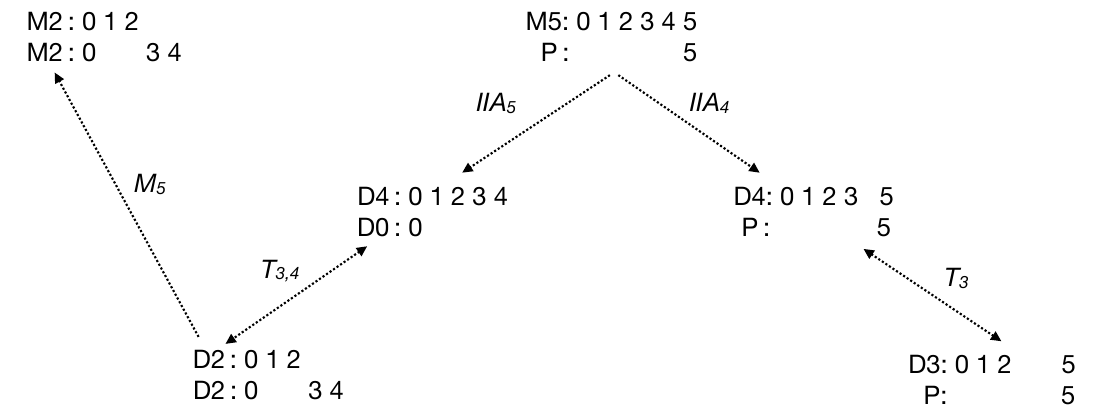
Figure 1 . U-dualities of an M5 with momentum. IIA n indicates reduction to string theory along x n , T n T-duality along x n and M n lift to M-theory along x n . ^ g 2 (cid:24) R =R R . If we now shrink the original radii to zero we obtain the strong coupling 5 3 4 Y M limit of N D 2-branes in a transverse R 7 or equivalently N M2-branes in a transverse R 8